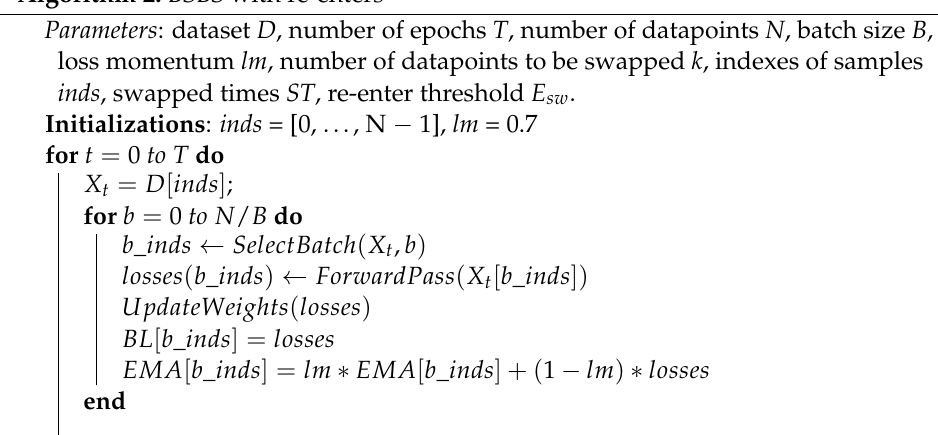
Algorithm 2: BSBS with